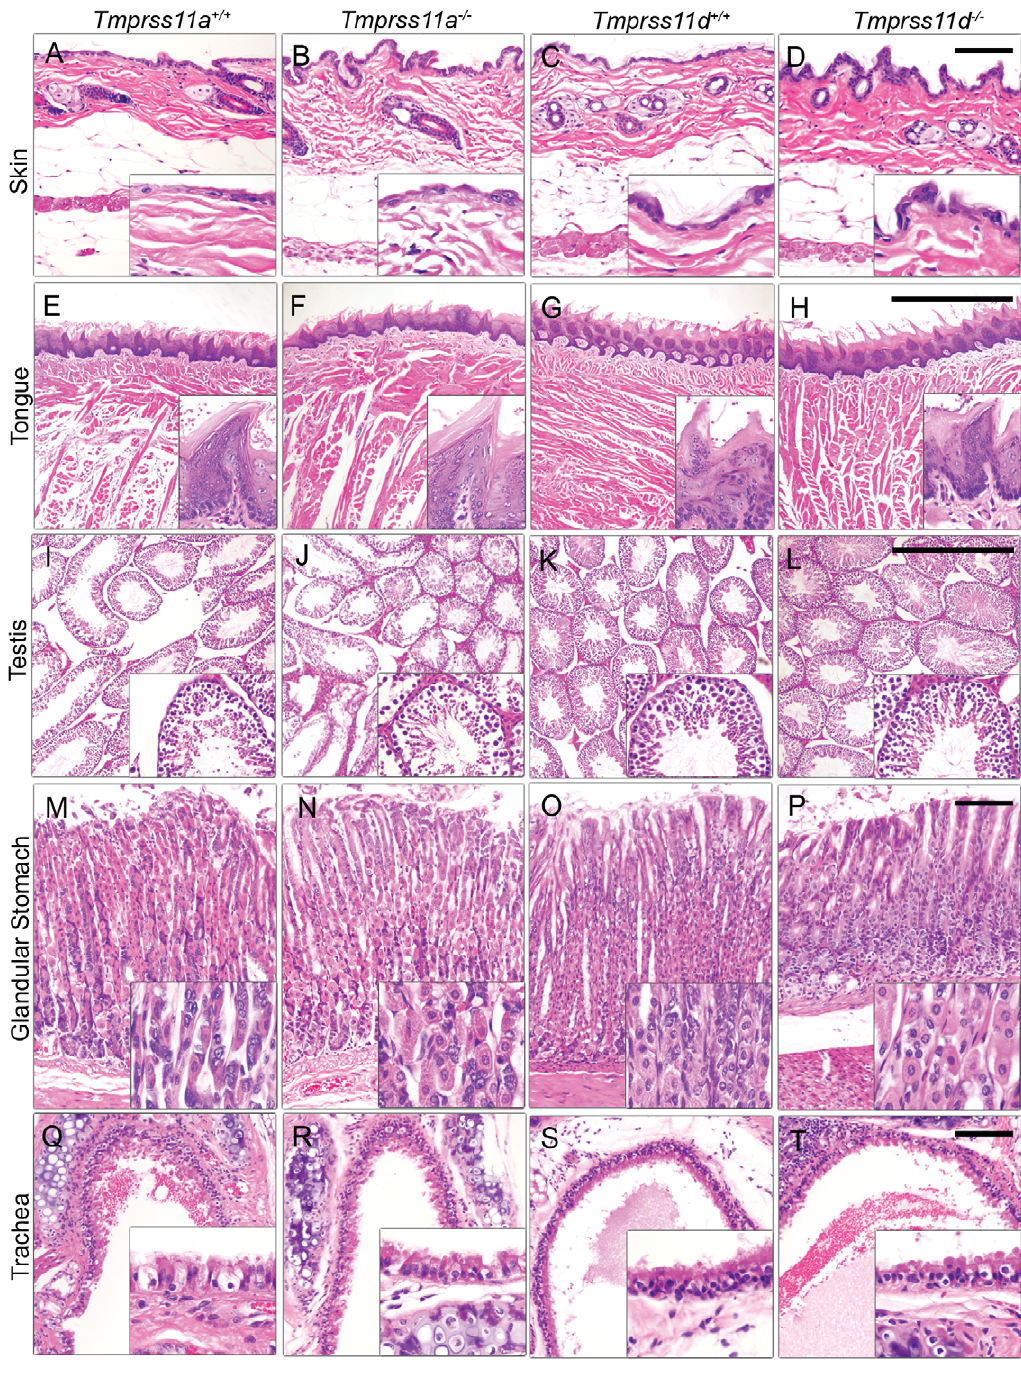
Figure 5. Microscopic appearance of tissues from aging HAT- and TMPRSS11A-deficient mice. Representative examples of the histological appearance of hematoxylin and eosin-stained sections of the skin (A–D), tongue (E–H), testis (I–L), glandular stomach (M–P), and trachea (Q–T) from 701–747 days-old Tmprss11a + / + (A, E, I, M, and Q) and littermate Tmprss11a 2 / 2 (B, F, J, N, and R) mice, and from 671–678 days-old Tmprss11d + / + (C, G, K, O, and S) and littermate Tmprss11d 2 / 2 (D, H, L, P, and T) mice. Inserts show higher magnification of boxed areas. Size bars in inserts are 100 m m.